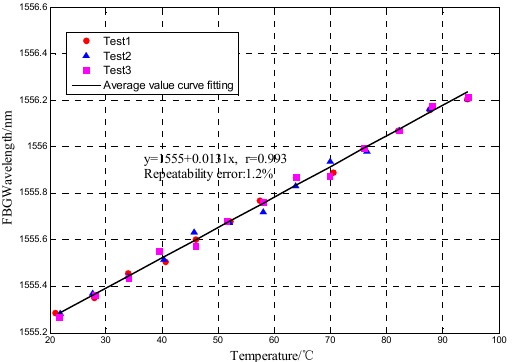
Figure 8. FP peak wavelength shift variation versus temperature. Sensors 2016 , 16 , 620